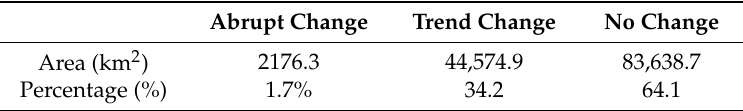
Table 2. Land cover changes in the study